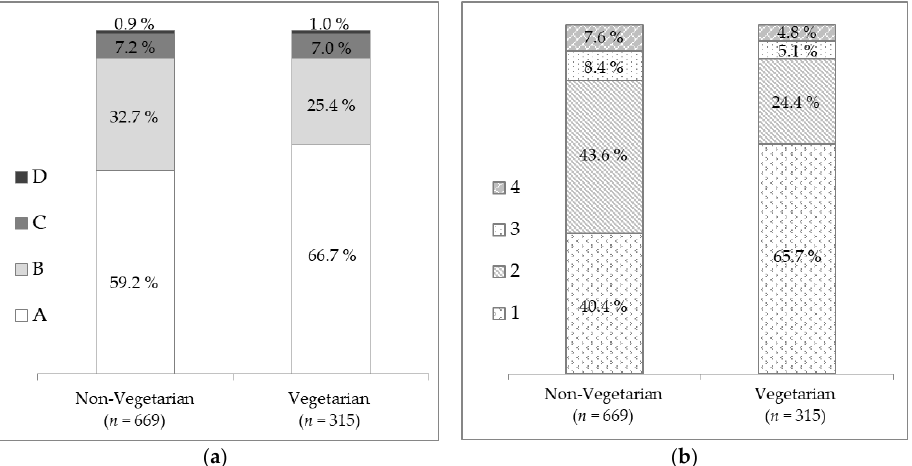
Figure 2. Nutrient profile of non-vegetarian ( n = 669) and vegetarian ( n = 315) main dishes according to ( a ) Nutri-Score classes (A, B, C and D); ( b ) SAIN,LIM classes (1, 2, 3 and